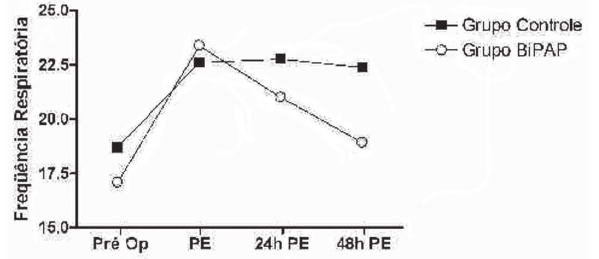
Fig. 3 – Distribuição representativa das alterações da Frequência Respiratória no pré-operatório, pós-extubação imediata, 24 e 48 horas pós-extubação em média, nos grupos Controle e BiPAP. Pré-op= Pré-operatório e PE= Pós-extubação. (P<0,001 intragrupos; P=0,265 intergrupos)